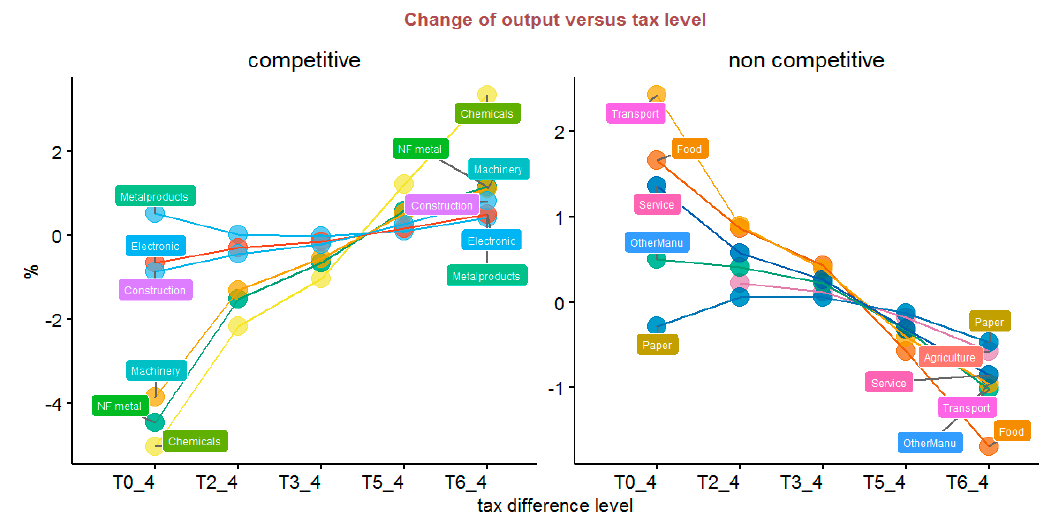
Figure 5. Output change compared with T4_4 of Guangdong Province in 2030.